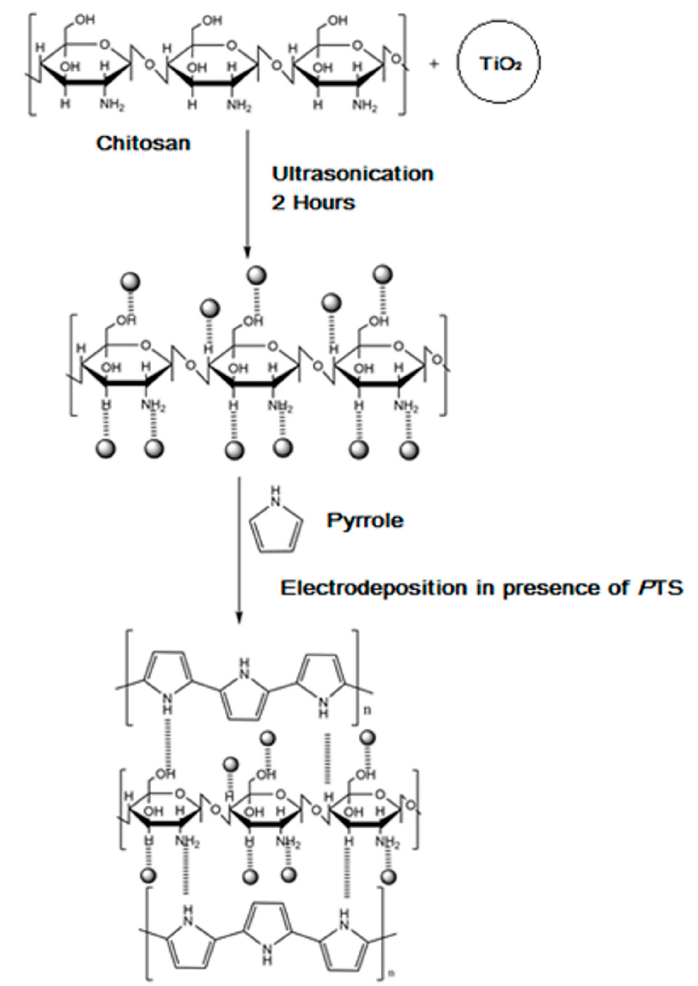
Figure 8. The mechanism of Ppy-CS-TiO 2 film electrodeposition.